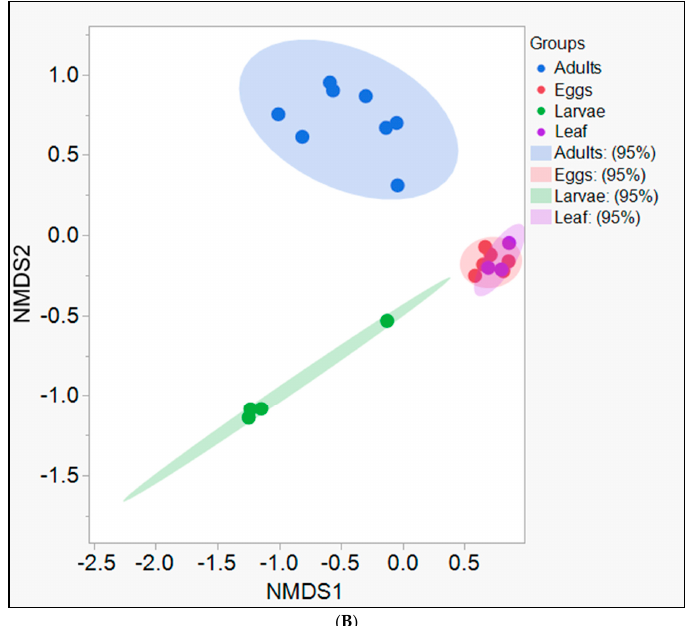
Figure 1. Microbiome dynamics vary across developmental stages (egg, larvae, and adults) of field-collected western bean cutworm Striacosta albicosta and its dietary material. ( A ) Boxplots of microbial species’ diversity and richness indices evaluated across developmental stages in this study. ( B ) Non-metric multidimensional scaling plot showing variations in microbiome composition among WBC developmental stages and its dietary material. The colors in panels A and B are not intended to mean the same things. Microorganisms 2022 , 10 , x FOR PEER REVIEW